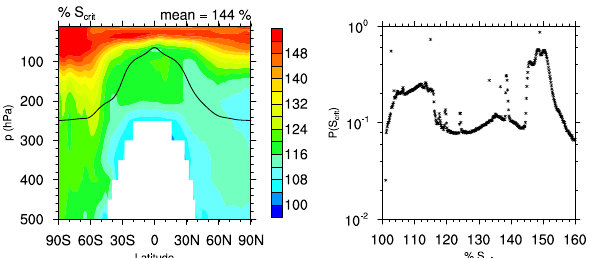
Figure 2. Annual zonal mean (left panel) and global frequency distribution (right panel) of the critical saturation ratio, S crit (%), for the cirrus regime ( T < 235K), obtained from 6h instantaneous GEOS-5 output over a 3-year subset (2002–2004) of the NEW run. Solid bold lines (left panel) represent the annual mean tropopause pressure.